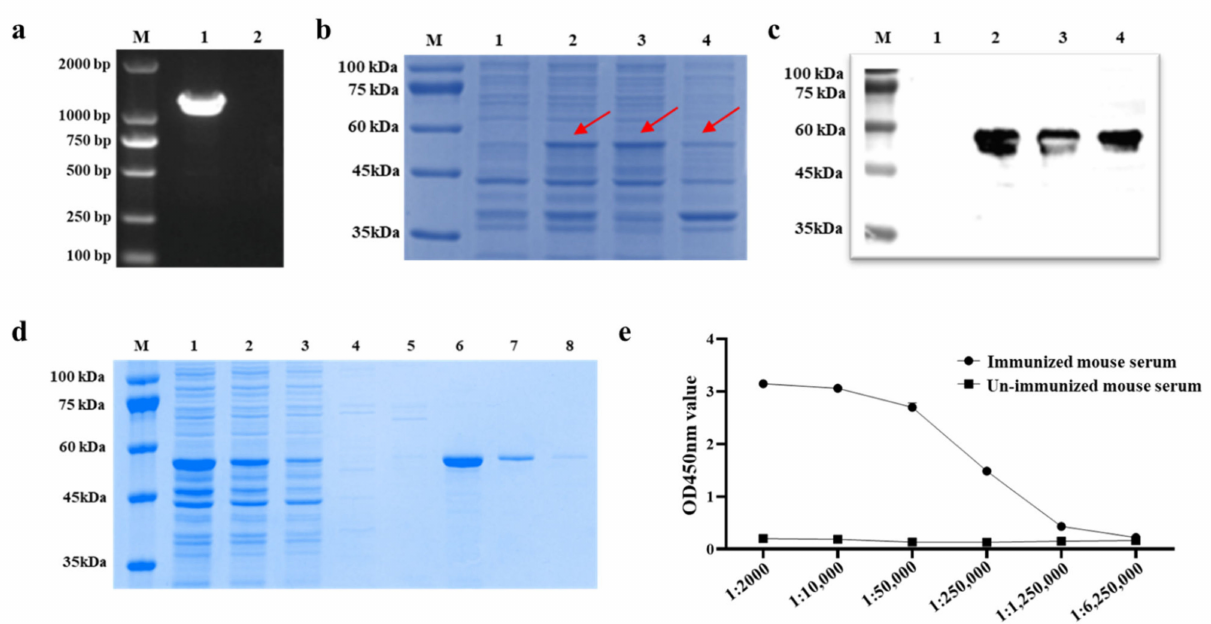
Figure 1. Expression, purification, and immunogenicity detection of IBV-N protein. ( a ) Amplification of the coding gene of IBV-N protein by PCR, around the target band of 1230 bp. ( b ) Expression and soluble analysis of IBV-N protein. M: Marker, Lane 1: pET-28a vector control, Lane 2: induced PET28a-IBV-N, Lane 3: the supernatant of induced PET28a-IBV-N, Lane 4: the inclusion body induced PET28a-IBV-N. Note: the red arrows point to protein expression of IBV-N protein. ( c ) Western blot analysis. ( d ) Purification of the IBV-N protein. Lane 1: the supernatant of un-purified IBV-N protein, Lane 2: the first liquid flowing from Ni-IDA column. Line 3–5: wash buffer for impurity, Line 6–8: elution buffer for target protein. ( e ) Analysis of the antigenicity of the IBV-N